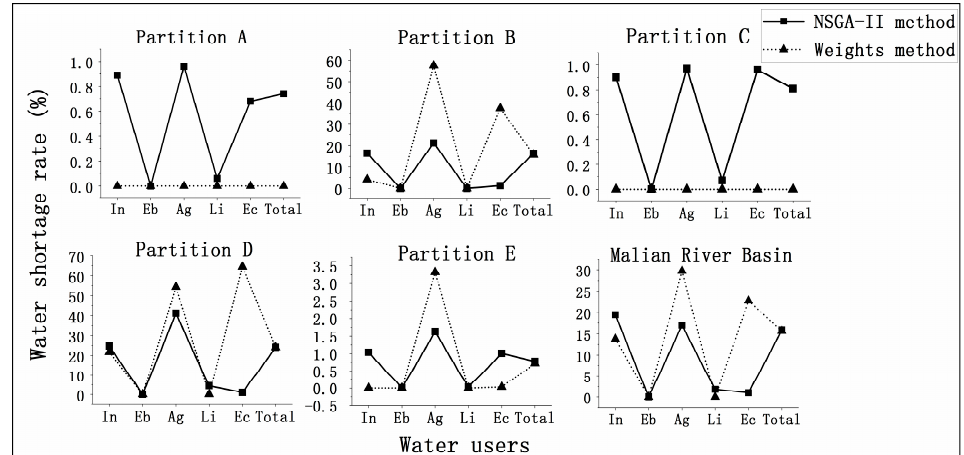
Figure 10. Comparative analysis chart of the model method and weights distribution method (In the figure, Pastoral Energy Industry Partition, Farming-Pastoral Industrial Development Partition,